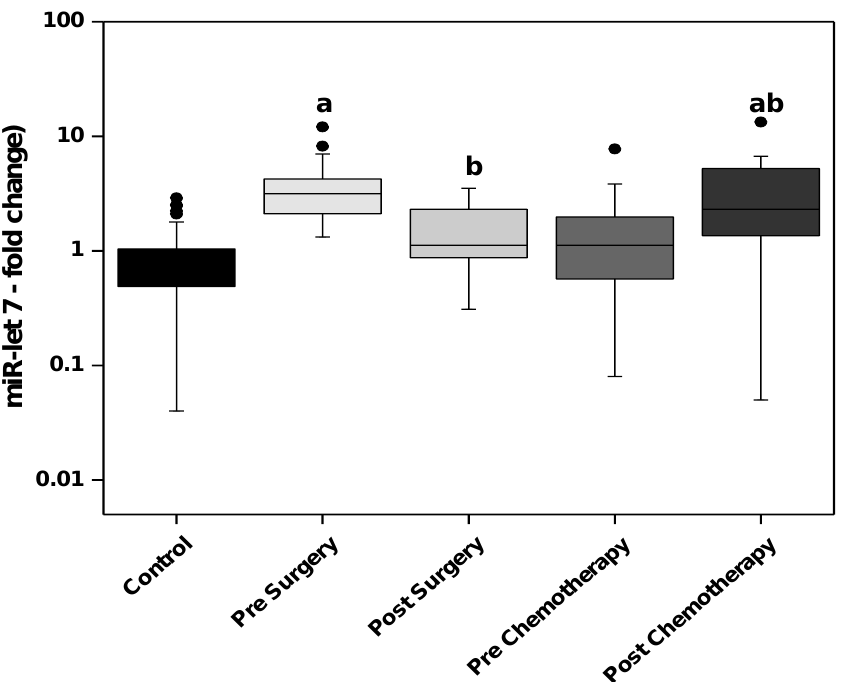
Figure 5. The circulating levels of miR-let 7 in the control subjects and the BC studied groups; surgery only and adjuvant chemotherapy. Extreme value: a—Significant between control and each group by using Post Hoc Test (Dunn’s), Kruskal Wallis test, b—Significant between pre and post in same group by using Wilcoxon signed ranks test.